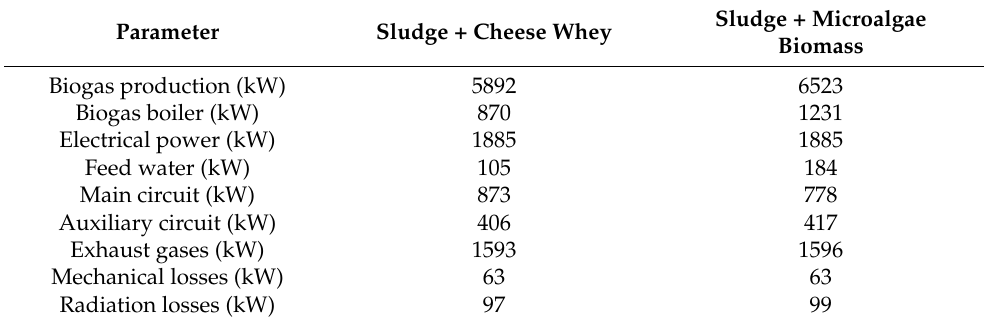
Table 9. Energy balance of biogas engines considering co-digestion with cheese whey and with hy- drolyzed microalgae. For simplicity, the same biogas yield after thermal pre-treatment was